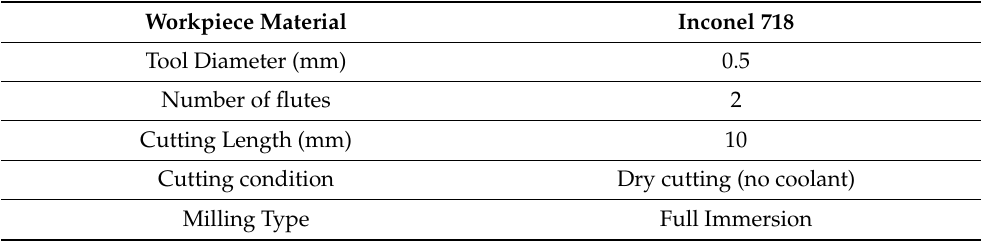
Table 2. Experimental conditions and